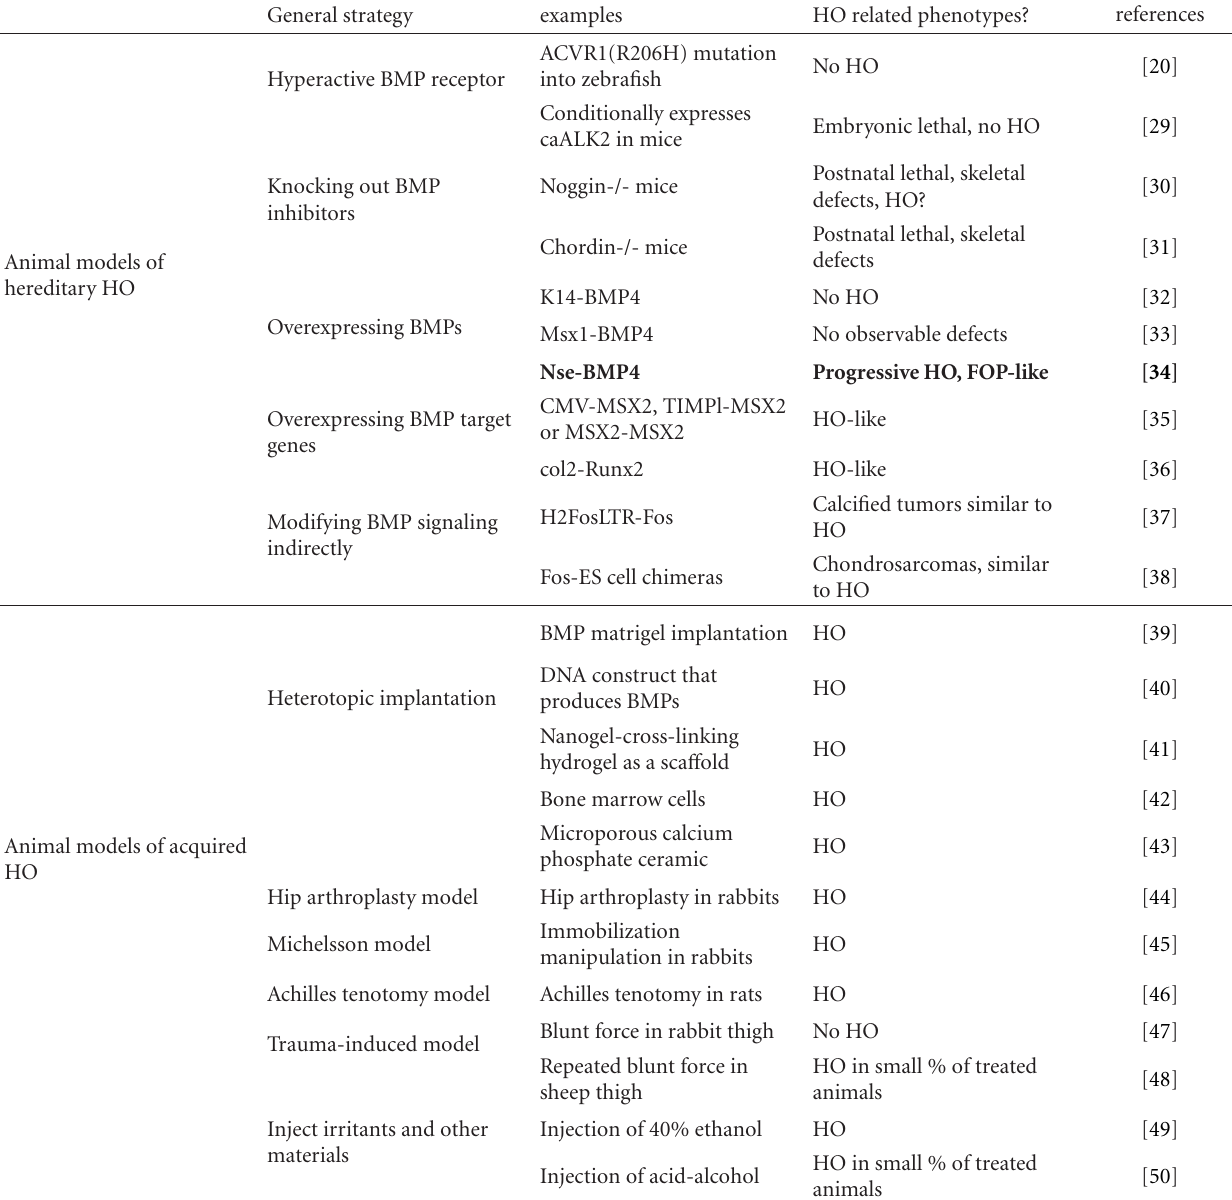
Table 1: Summary of commonly used animal